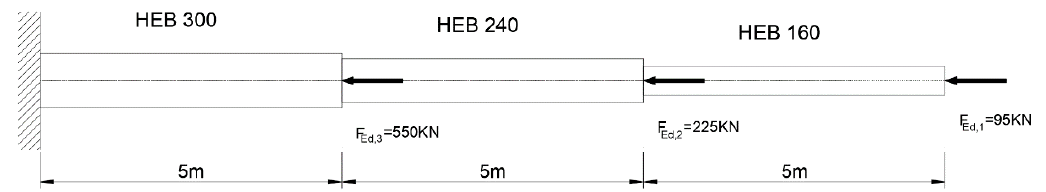
Figure 14. Example 5: description taken from [24].